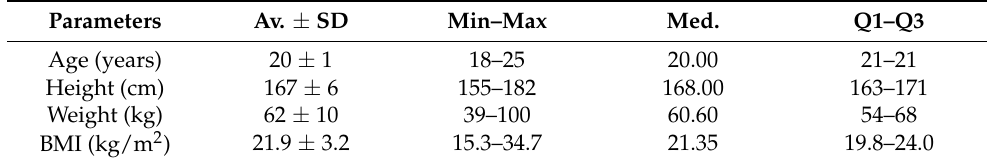
Table 1. Characteristic of study group ( n =